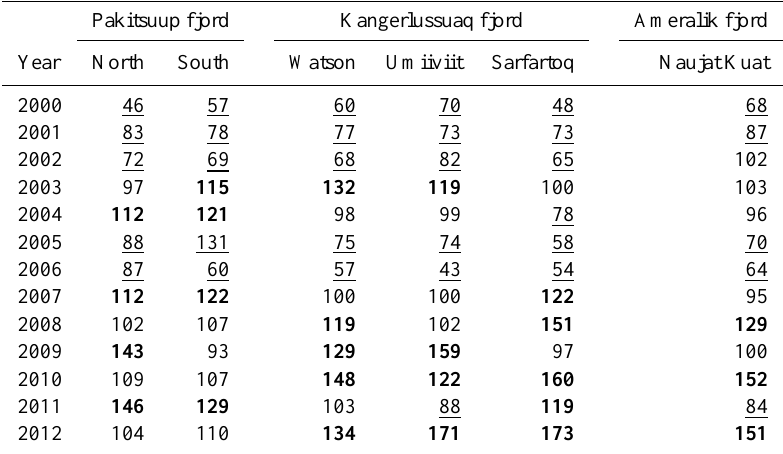
Table 4. Percent available fjord pixels in a melt season above 50mgL − 1 ( P > 50 ) as a percent of statistics’ 13 year mean. Underlined values are statistically below the mean, bold values statistically above.